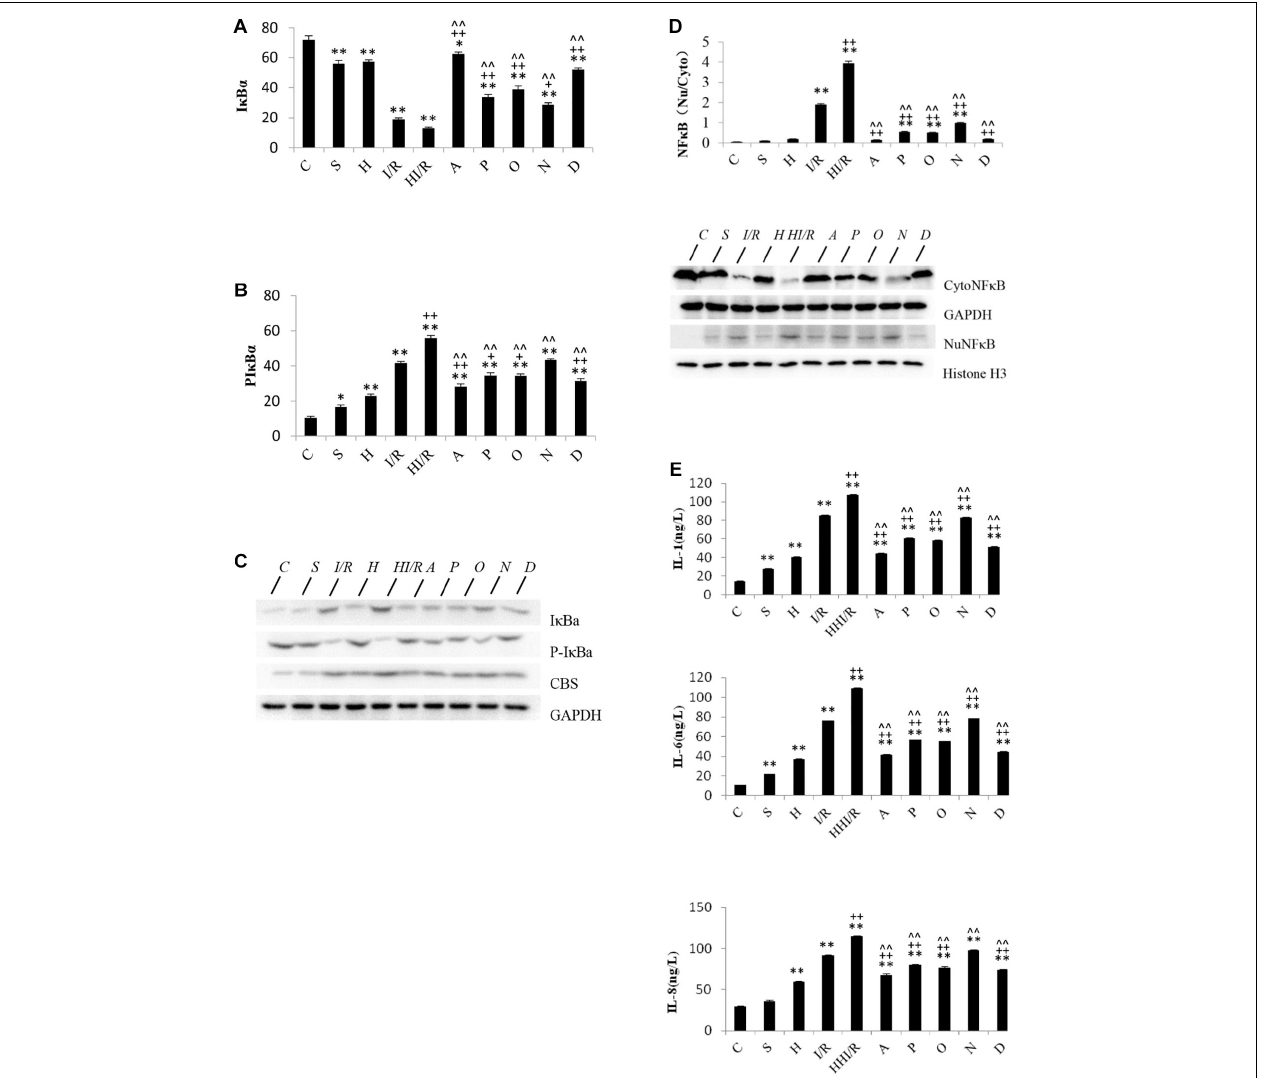
FIGURE 5 | Changes of I κ B α , p-I κ B α , and NF κ B translocation, IL-1, IL-6, and IL-8 levels in cerebrum tissue in rats 24 h after I/R or not. (A) I κ B α levels decreased significantly in all other groups, compared to the C group ( P < 0.05 or 0.01). The first and second lowest I κ B α levels appeared in the HI/R and I/R groups, respectively ( P < 0.01), and increased by all inhibitors ( n = 3, P < 0.05 or 0.01). (B) The first and second lowest P-I κ B α levels appeared in the HI/R and I/R groups, respectively ( P < 0.01). Significant decrease of p-I κ B α levels appeared in all inhibitor groups than in the HI/R group, but appeared in A, P, O, and D groups when compared to the I/R group ( n = 3, P < 0.05 or 0.01). (C) The blot band demonstrated changes of I κ B α , p-I κ B α , and CBS protein levels in each group. GAPDH was used as normalized protein. (D) Translocation of NF κ B levels into nuclear evidently increased in I/R and HI/R groups compared to control group, and decreased